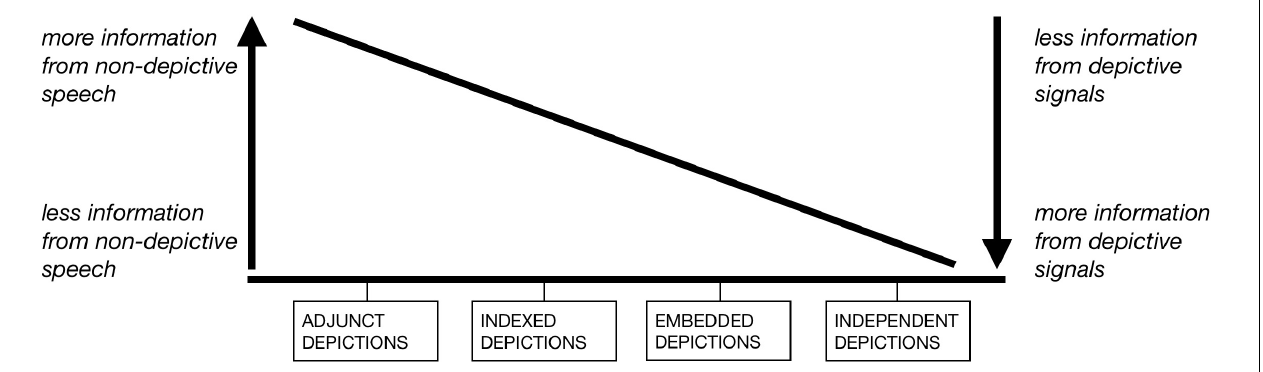
FIGURE 5 | Continuum of information contribution from non-depictive speech and depictive signals.